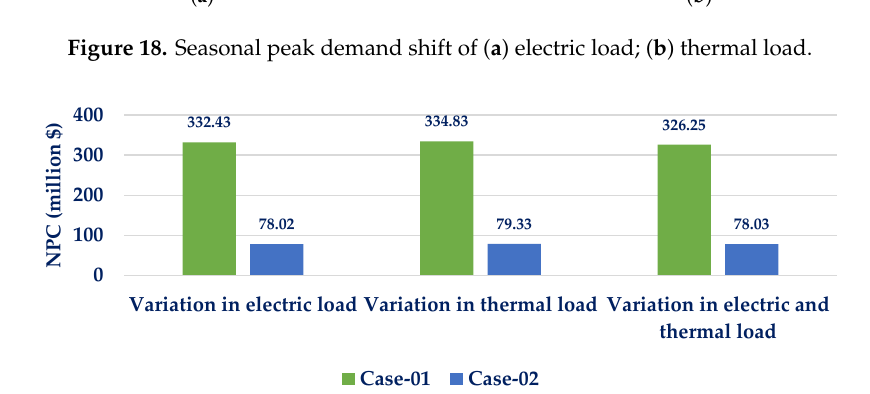
Figure 18. Seasonal peak demand shift of ( a ) electric load; ( b ) thermal load. Figure 19. Impact on NPC due to seasonal peak demand variation. Figure 19. Impact on NPC due to seasonal peak demand Figure 19. Impact on NPC due to seasonal peak demand variation.